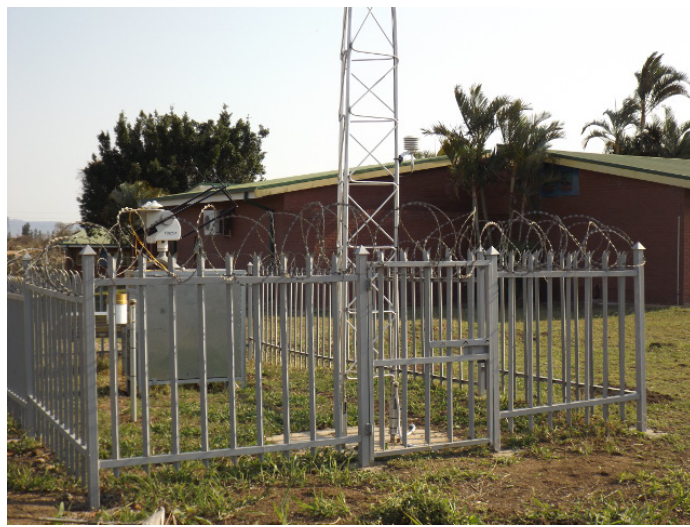
Figure 1. USAid Venda